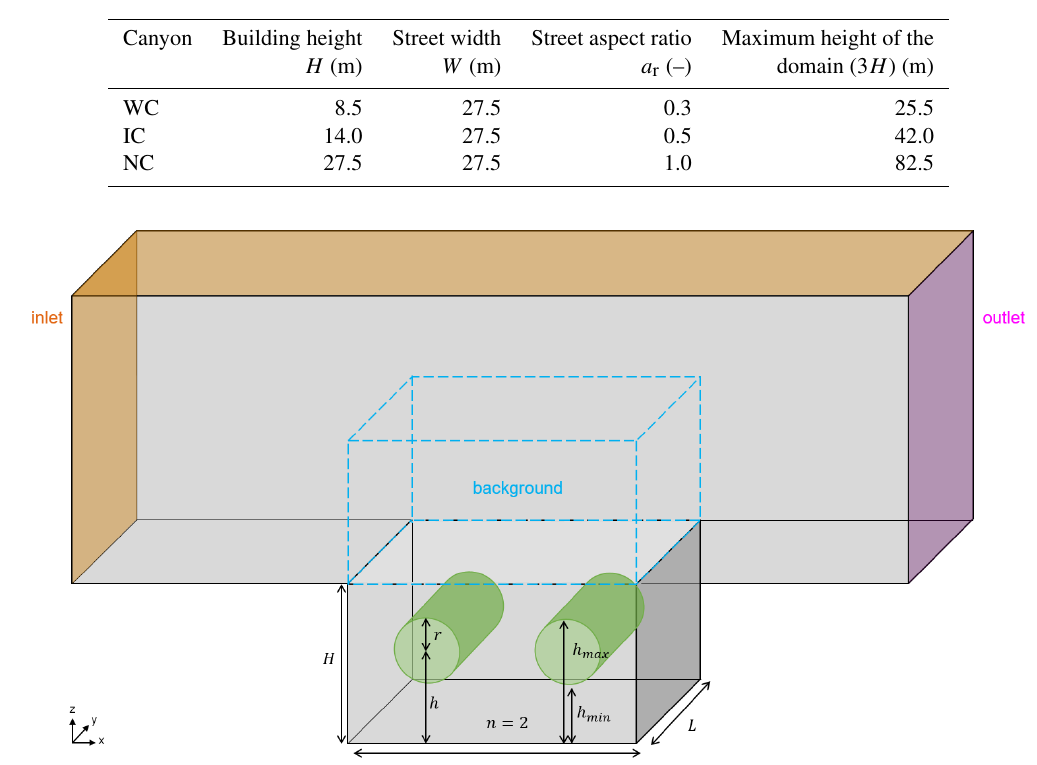
Figure 1. The 3D scheme of the street canyon with cylindrical tree crown